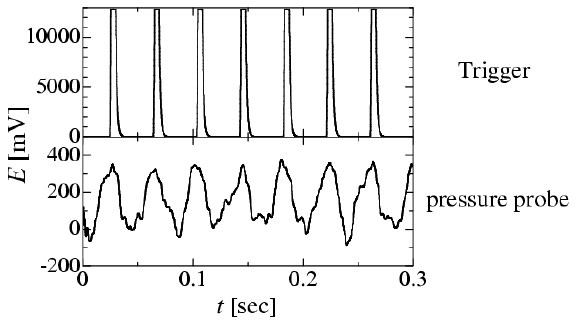
Fig. 8 Time history of static pressure signal (Measurement position 1-b; FOOT